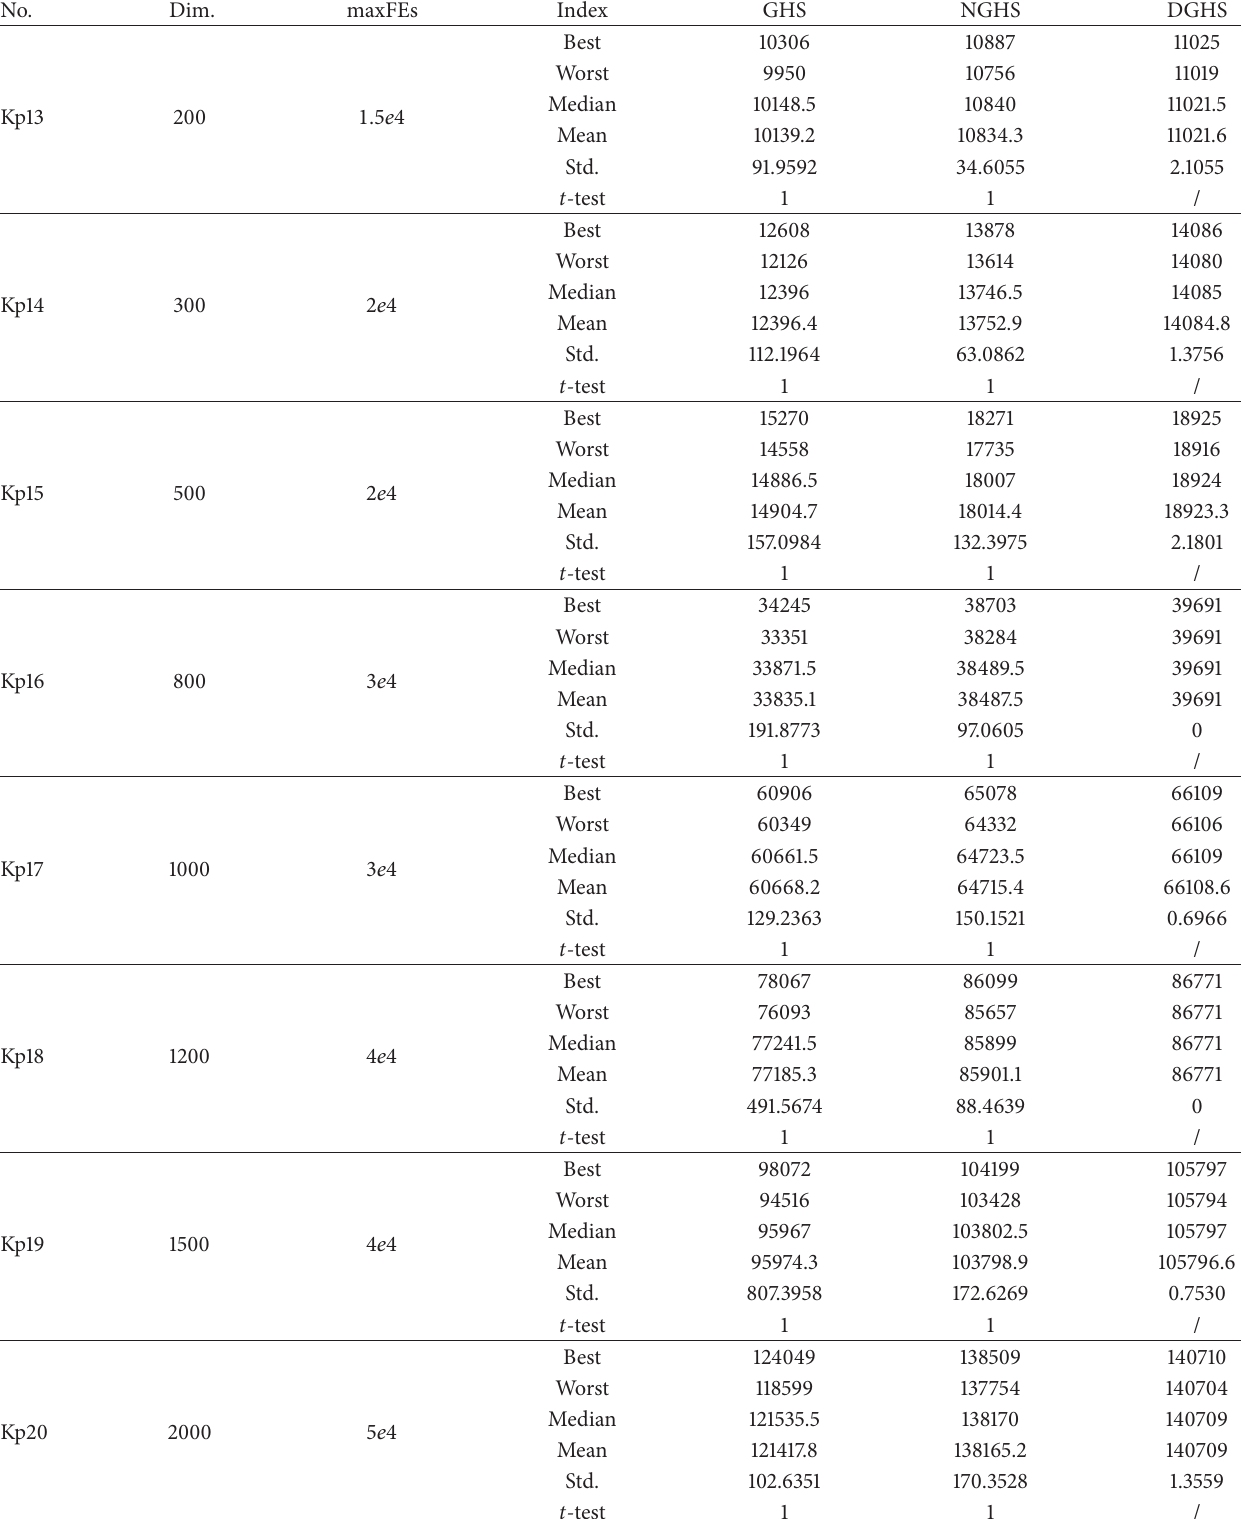
Table 5: Comparison among GHS, NGHS, and DGHS on the high-dimensional 0-1 knapsack problems. No. Dim.